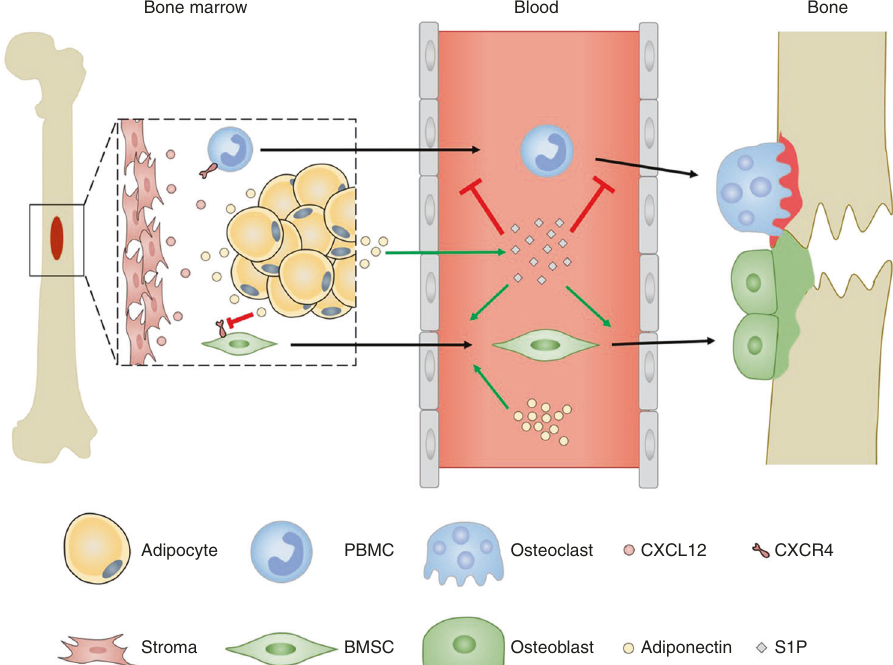
Fig. 2 Adiponectin regulation of osteoblast and osteoclast migration. Osteoblast progenitors must exit the bone marrow niche to migrate towards the sites of resorption and/or damage. In fate mapping experiments, YFP expressing bone marrow-derived osteoblast precursors migrated to the endosteal surface to replenish osteoblast populations in healthy conditions and also in response to calvarial microfracture. 41 Osteoblast and osteoclast progenitors express CXCR4 and migrate towards high levels of CXCL12 causing them to be retained in the bone marrow. 42 Adiponectin directly 40 and through increasing S1P in the serum, 17 leads to increased osteoblast progenitor migration into the circulation and to bone in health, 48 which is enhanced during injury. 41,116,117 In contrast, S1P chemorepels osteoclast progenitors and osteoclasts, 51 leading to decreased migration to damaged sites. This ultimately maintains the balance between resorption (red) and formation (green) to ensure structured bone